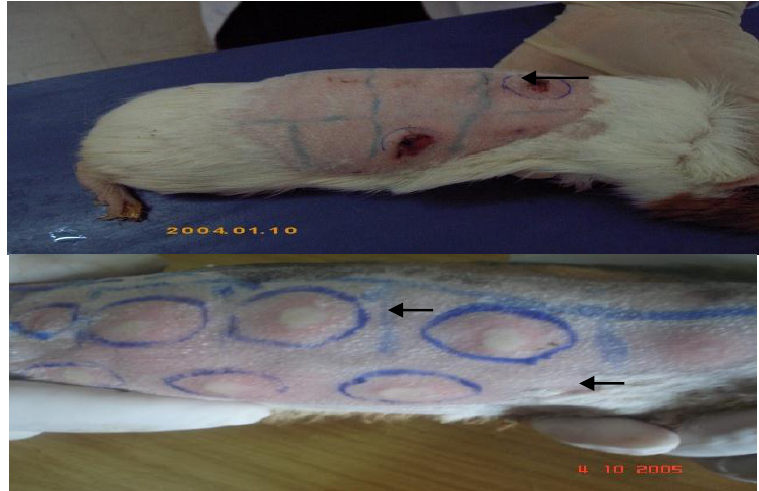
Figure (2) Permiability factor in Guinea pig skin I. d injected by CT ( purified CT) top and (crude extract of CT) below